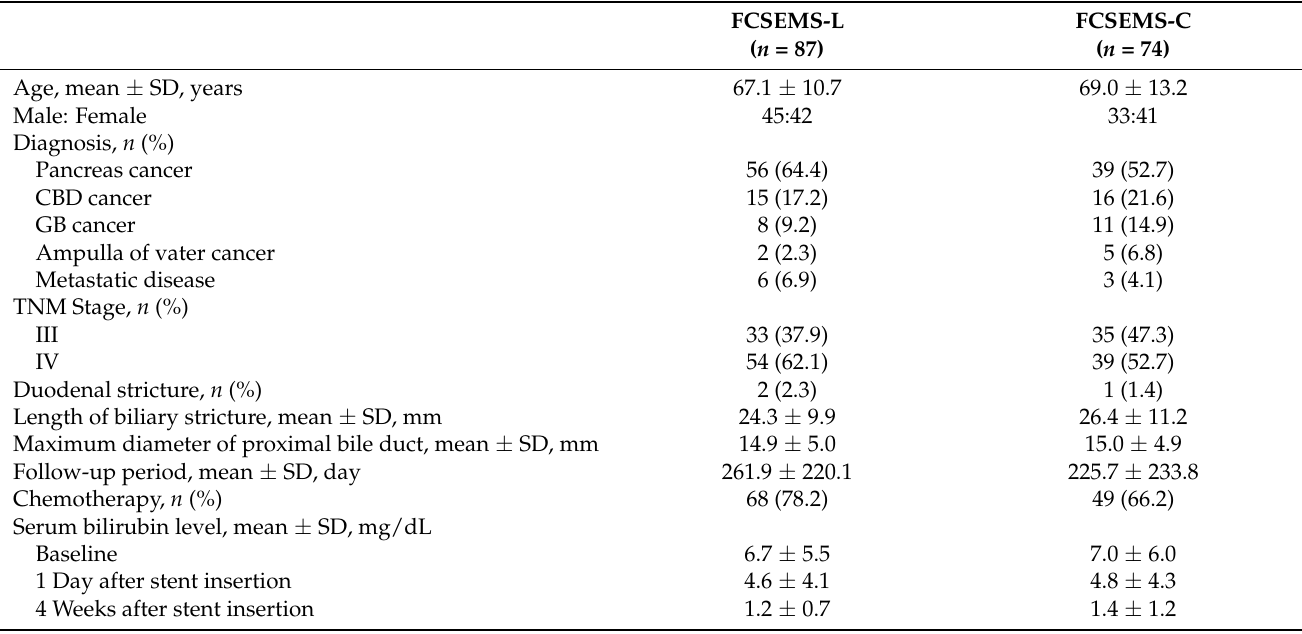
Table 1. Basic patient